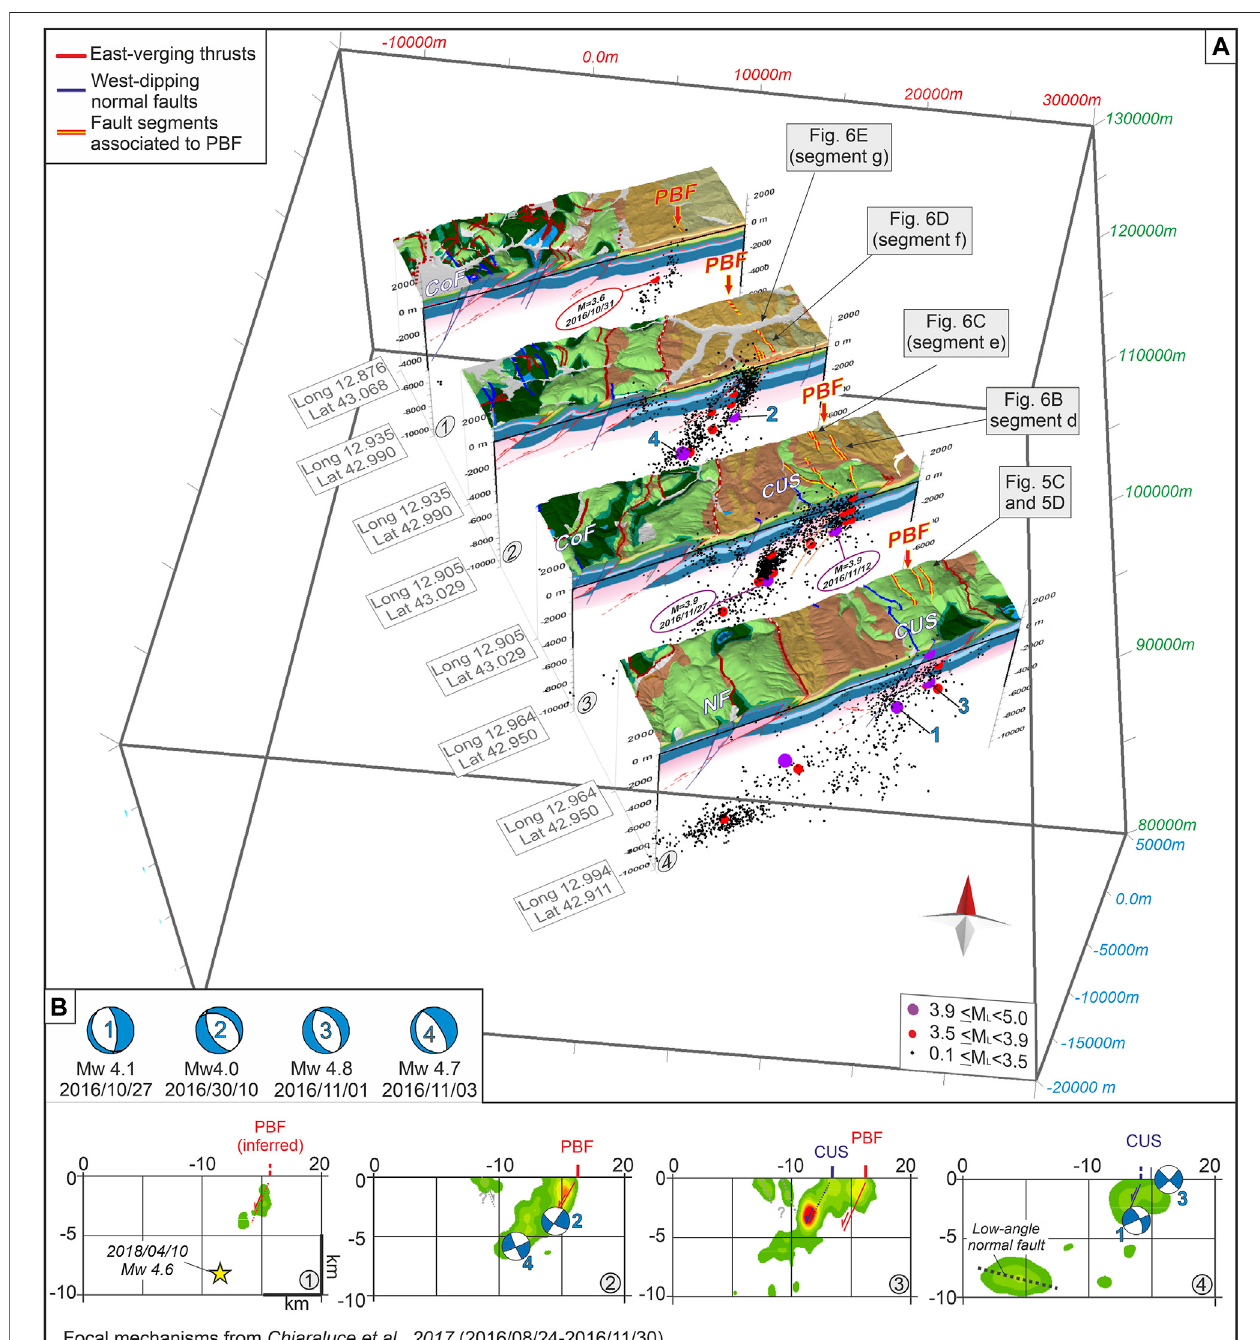
FIGURE8| Block-diagramofearthquake/faultassociationanddensitycontoursoftheseismicityalongthecross-sections(1 – 4,tracesin Figure1B )drawnforthe investigatedarea(hypocentersarefromChiaraluceetal.(2017)). (A) 3Dblockmodelshowingthemainstratigraphicunits(atthesurface)andthehypocentraldistribution of the seismicity within a half-width of 2.5 kmalong the cross-sections reported in Figure 7 . Stratigraphic information coming from the maps at different scales (see text for details) has been synthesized. Fault key as in Figure 1C . The normal fault segments highlighted in this study and ascribed to the Pievebovigliana fault (PBF) are presented and compared with the in-depth distribution of the most energetic events falling in the sector (the data frame reference system is WGS84/UTM 33N). (B) density contours alongcross-sections 1to4showingthe seismicity density aroundthe PBFand CUS (Cupi-Ussitasections oftheVBF, asinBrozzetti et al.(2019)).The focal mechanisms with M w ≥ 3.9 falling within the considered buffer have been also projected. The hypocenter of the April 10, 2018 event (yellow stars) is from Scognamiglio et al. (2006). Numbers are the same as in Figure 2C .